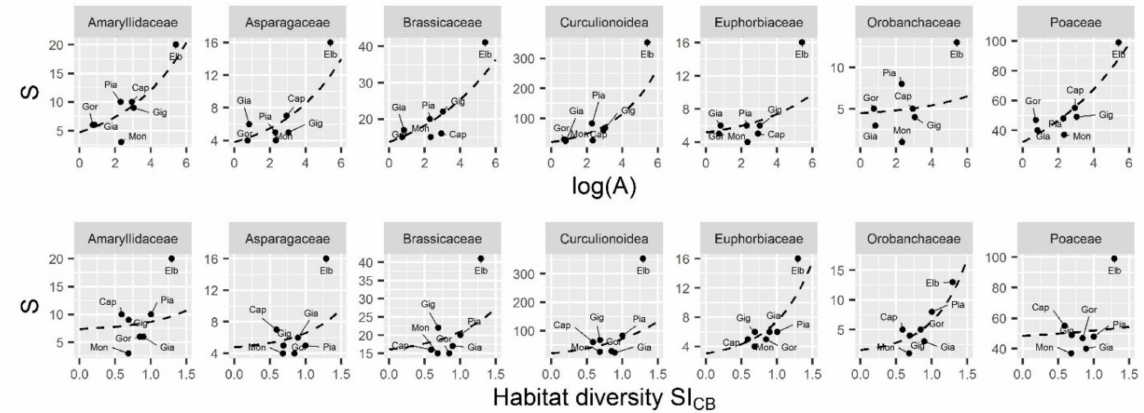
Figure 5. Species-Area Relationship combined with Habitat Diversity Hypothesis (SAR + HDH) according to the Logarithmic function: Joint effect of the logarithm of island area (log(A)) and effect of habitat diversity (SI CB : Shannon’s Index on CORINE Biotopes) on species richness (S) of animal and plant taxa in the Tuscan Archipelago.